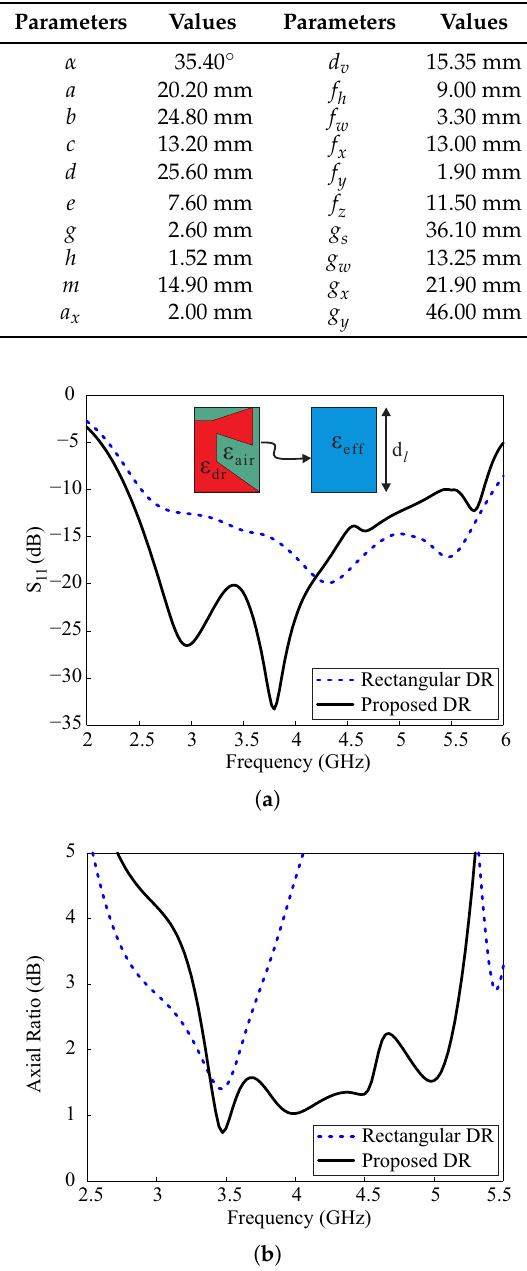
Figure 5. Comparison between the proposed and a rectangular dielectric resonator: ( a ) reflection coefficients; ( b ) axial